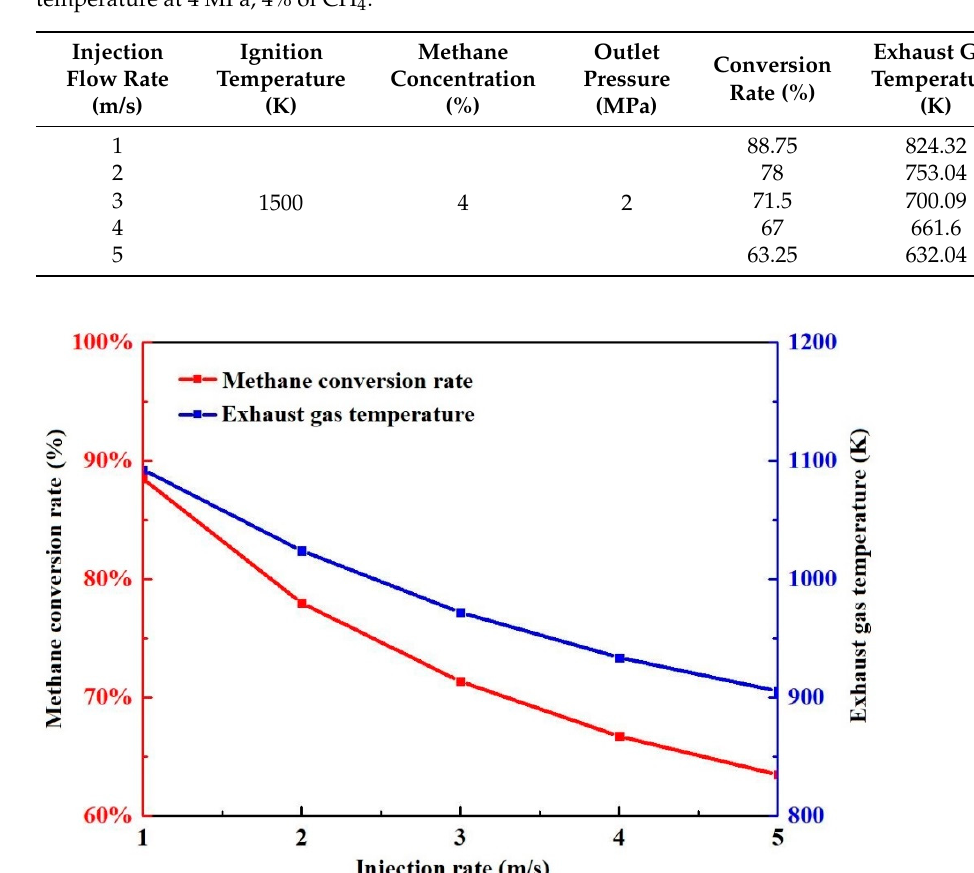
Figure 19. The influence of injection rate on conversion rate and exhaust gas temperature at 2 MPa, 4% of CH 4.